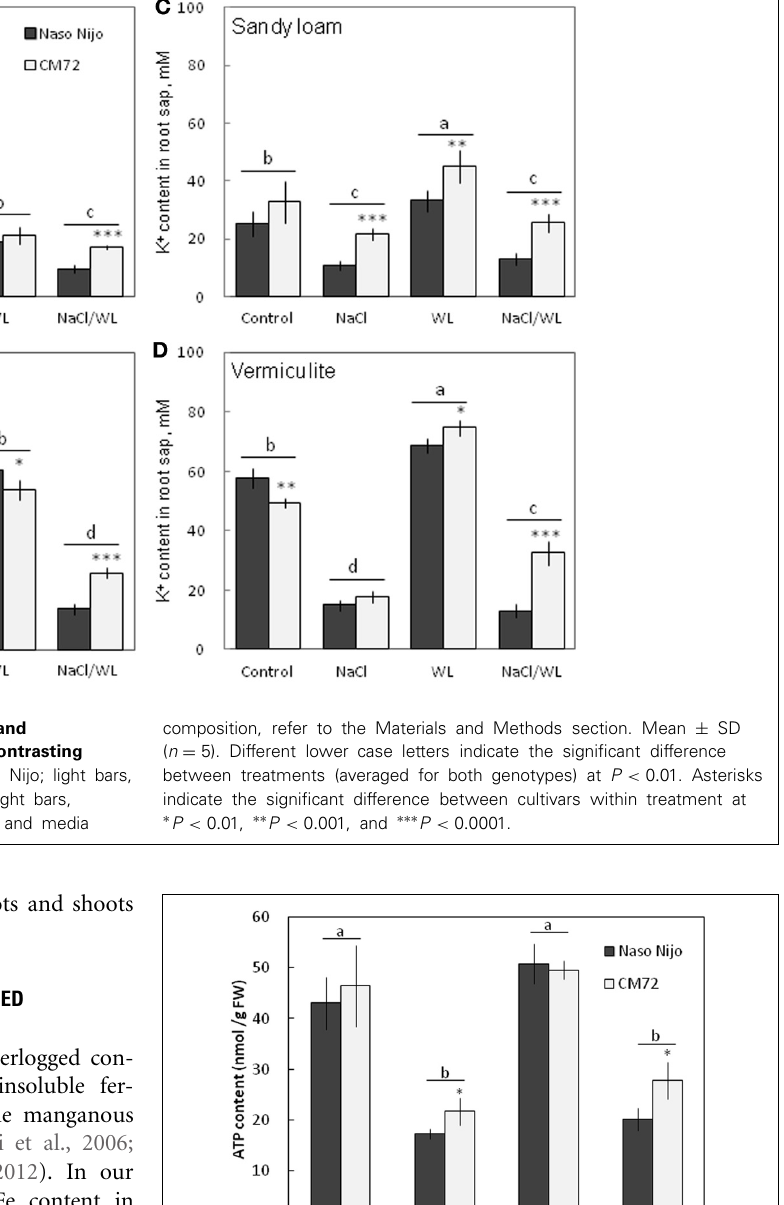
FIGURE 10 | ATP content in barley roots grown under normoxic and hypoxic conditions for 14 days. Closed bars—Naso Nijo; open bars—CM72. Mean ± SD ( n = 4 plants). Different lower case letters indicate the significant difference between treatments (averaged for both genotypes) at P < 0 . 01. Asterisk indicate the significant difference between cultivars within the treatment at ∗ P < 0 .